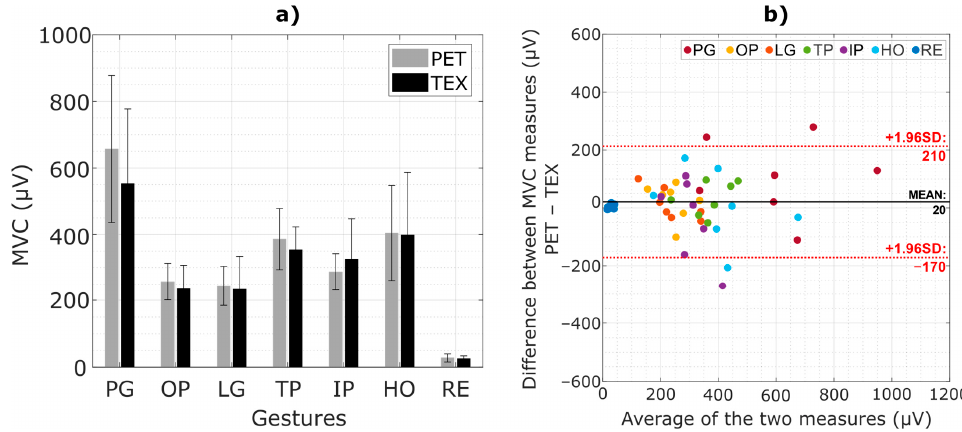
Figure 10. ( a ) Averaged MVC values (mean ± std) across participants grouped by gestures. ( b ) Bland-Altman plot of the MVC measures for all participants. Each colour represents a gesture. A solid line corresponds to the bias and red dashed lines indicate the limits of agreement. (PG: power grasp, OP: one finger pinch, LG: lateral grasp, TP: three fingers pinch, IP: index pointing, HO: hand open, RE: